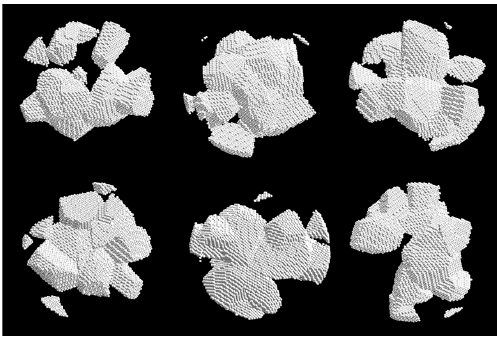
Fig. 17. A two-mode sea salt aerosol size distribution from Porter and Clarke (1997) for ocean wind speed between 5.5 and 7.9ms − 1 . The dotted curve denotes fine-mode size distribution; the dashed curve denotes coarse-mode size distribution. The combined size dis- tribution is denoted by the solid